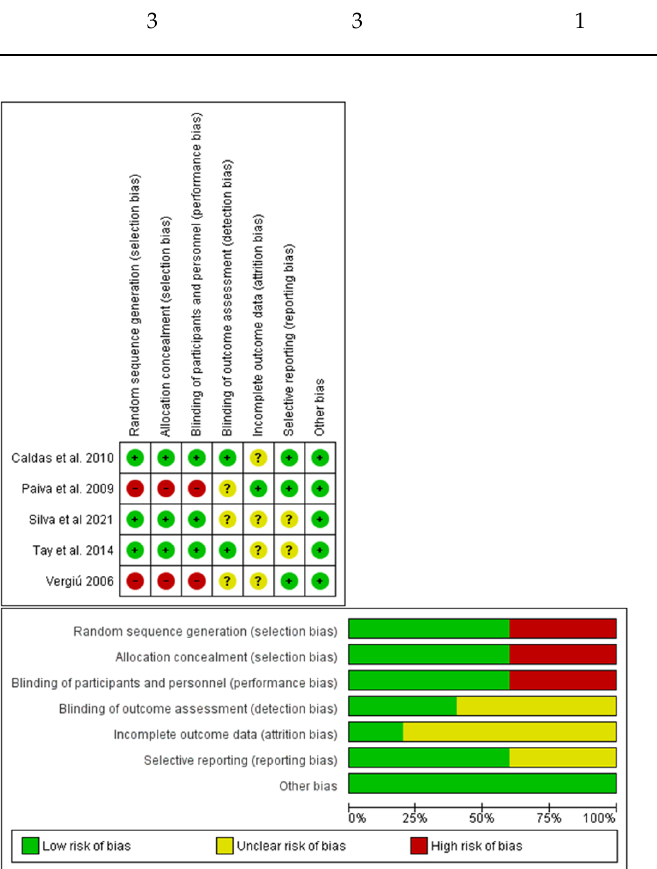
Figure 2. Risk of bias graph for each of the studies included in this review; Tay et al. 2014 [21], Paiva et al. 2009 [27], Silva et al. 2021 [28], Vergiú 2006 [29], Caldas et al. 2010